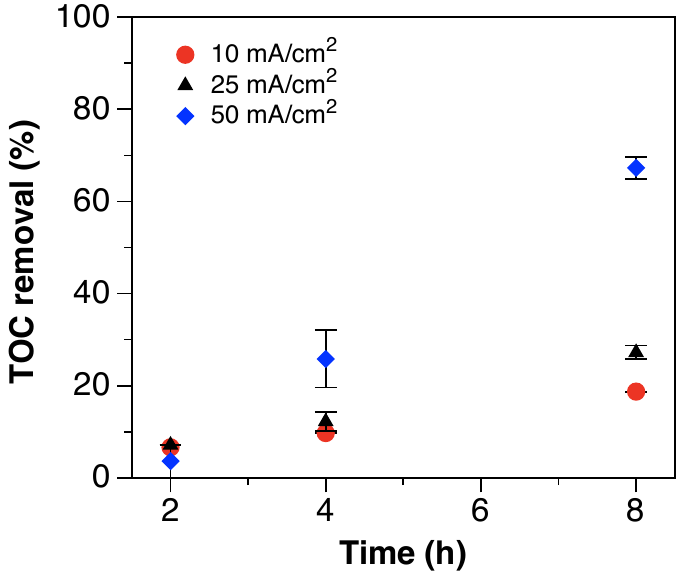
Figure A2. TOC removal over time during the electrochemical treatment of a synthetic still bottoms solution. The applied current densities were: 10 mA/cm 2 , 25 mA/cm 2 , and 50 mA/cm 2 .